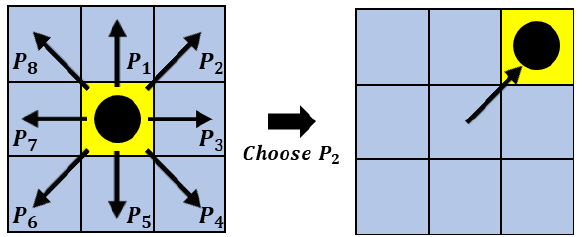
Figure 1. Movement of an agent in FFM